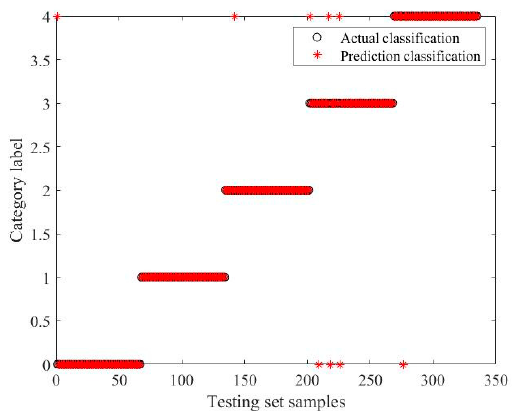
Figure 12. The classification results of the PFCM-ABC-SVM method when the Gaussian noise variance is 1.0.